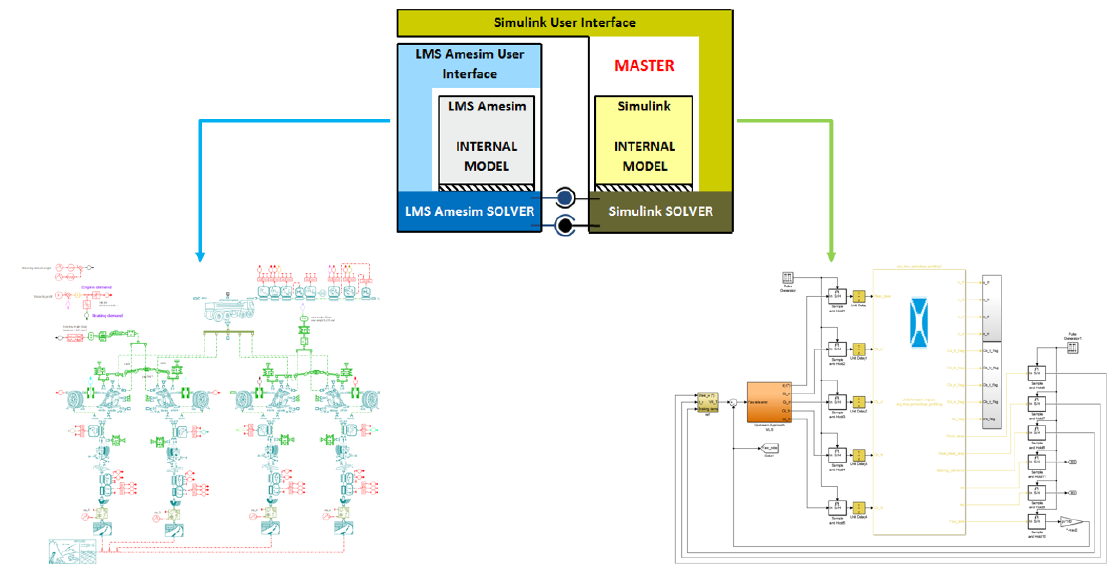
Figure 17. Co-simulation